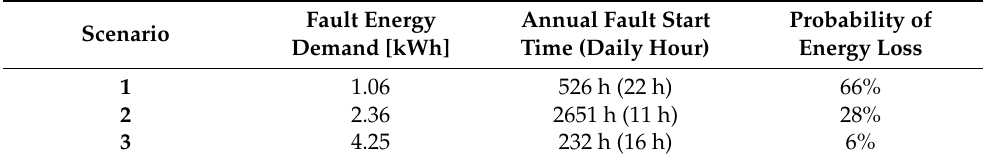
Table 7. Detail of the identified scenarios for the stochastic planning problem of a residential client.